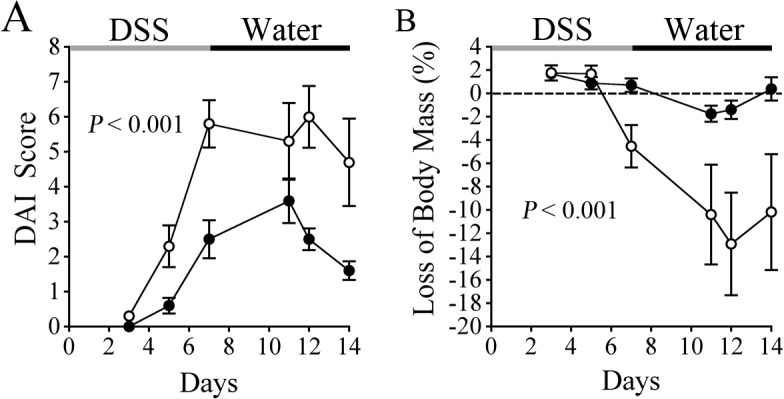
Genetic elimination of FXIII prolongs colitis symptoms.FXIII−/− mice (◯) challenged with DSS develop significantly worse clinical signs of disease relative to WT mice (●) based on a multiparameter Disease Activity Index score (A) and weight loss (B). Note that body mass continued to decline in FXIII−/− mice even after DSS was withdrawn, whereas body mass stabilized and improved in WT animals during this period. P values were generated with a 2 way ANOVA, n = 10 mice per cohort.